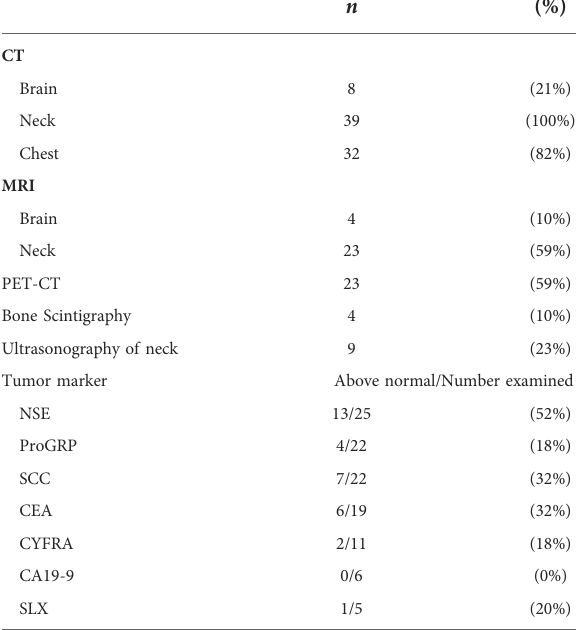
TABLE 3 Pretreatment